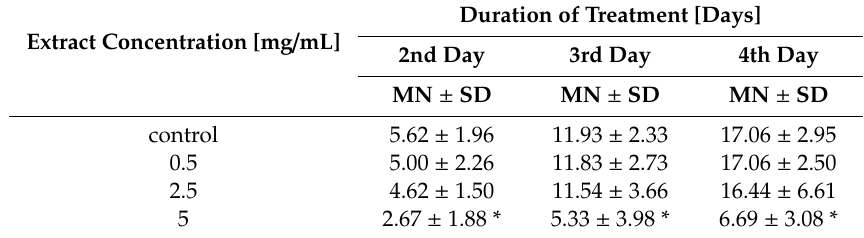
Table 3. The e ff ect of the extract from shoots from in vivo plant of Eryngium alpinum L. [0.5 mg / mL, 2.5 mg / mL, 5 mg / mL] on inhibition of Acanthamoeba trophozoites during four days of treatment.